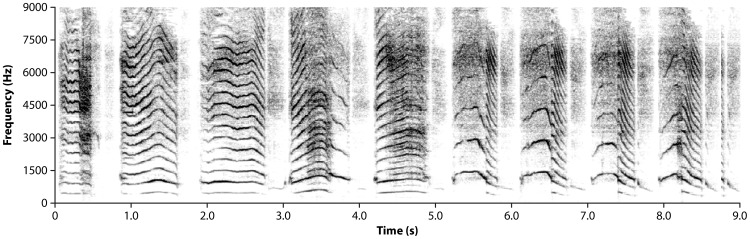
Spectrographic Display of Human Infant Crying.This figure shows the standard phonated harmonic structure of crying evident in the first 3 expiratory cry sounds, followed by expiratory cry sounds with hyperphonation, evident at the end of the fourth cry expiration and in cry expirations that occurred after 5 sec. A greater vertical distance between harmonic frequencies denoted by horizontal lines characterizes this acoustic structure. This figure is an example of finding the highest Peak F0 in the crying bout beyond the initial three cry expirations often used in previous studies of cry analysis.